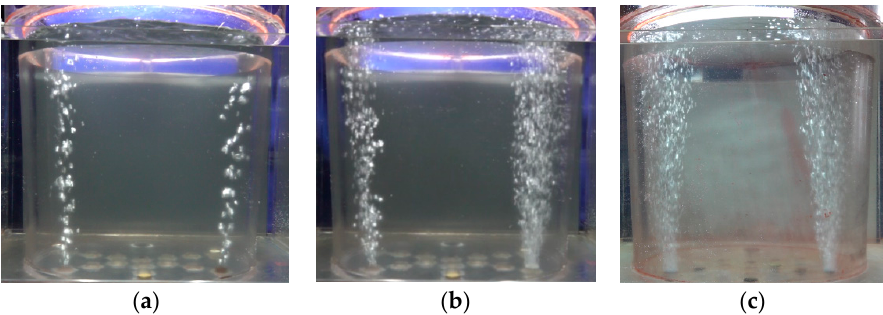
Figure 9. The characteristics of flow field with different bottom stirring mode traced by ink: ( a ) slot + slot plug, ( b ) slot + porous plug, and ( c ) porous + porous plug.